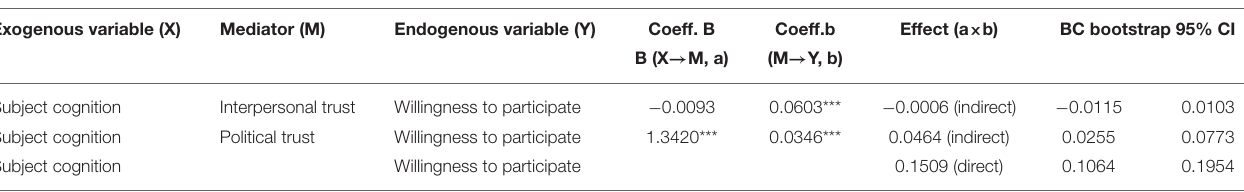
TABLE 6 | Results of mediation analysis with